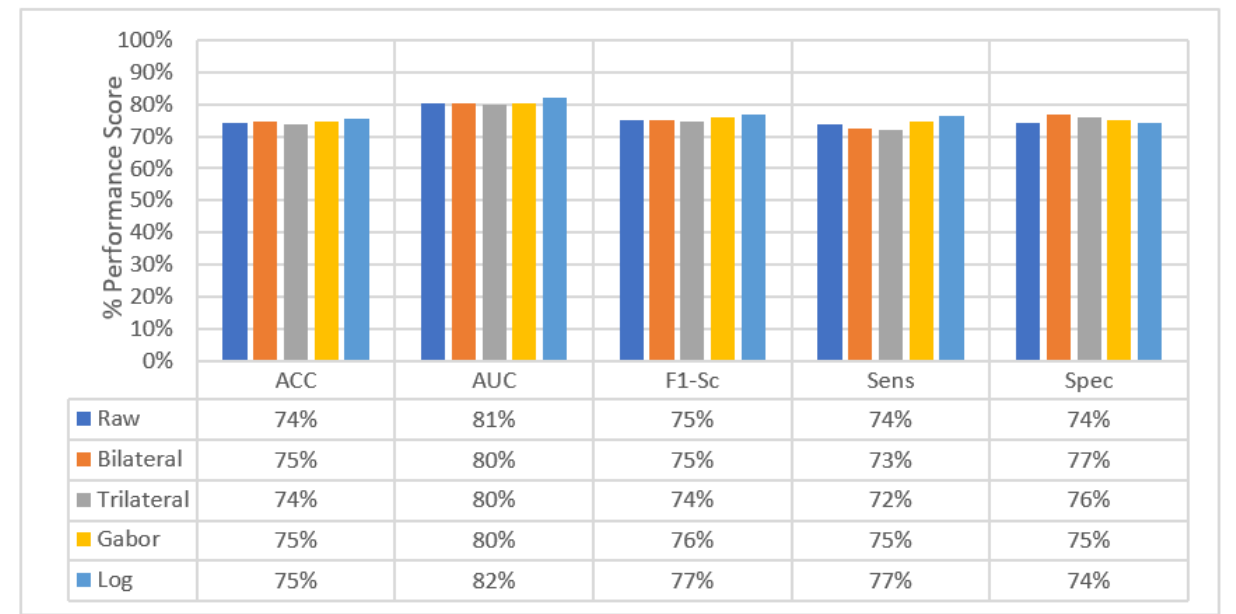
Figure 33. Change in average slice level classification performance of the proposed classifiers over three perspectives.